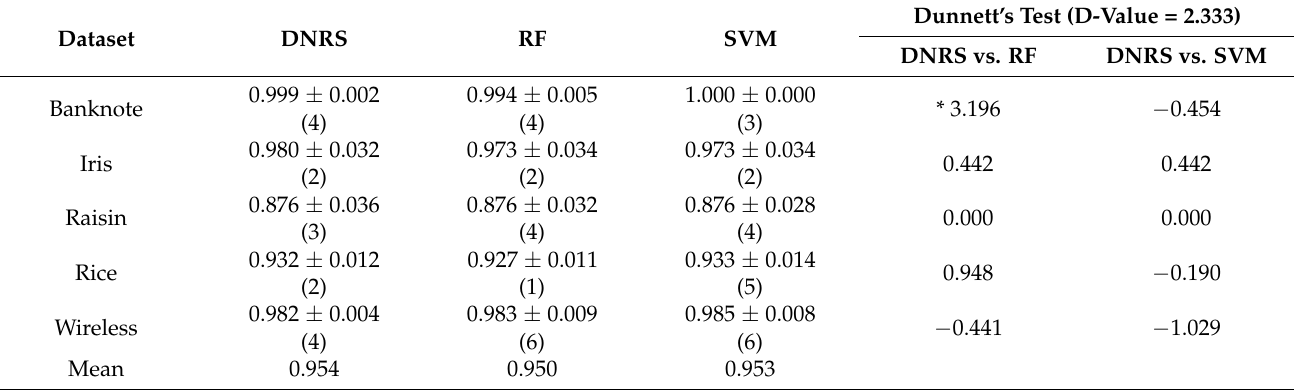
Table 13. Comparison of classification accuracy and Dunnett’s